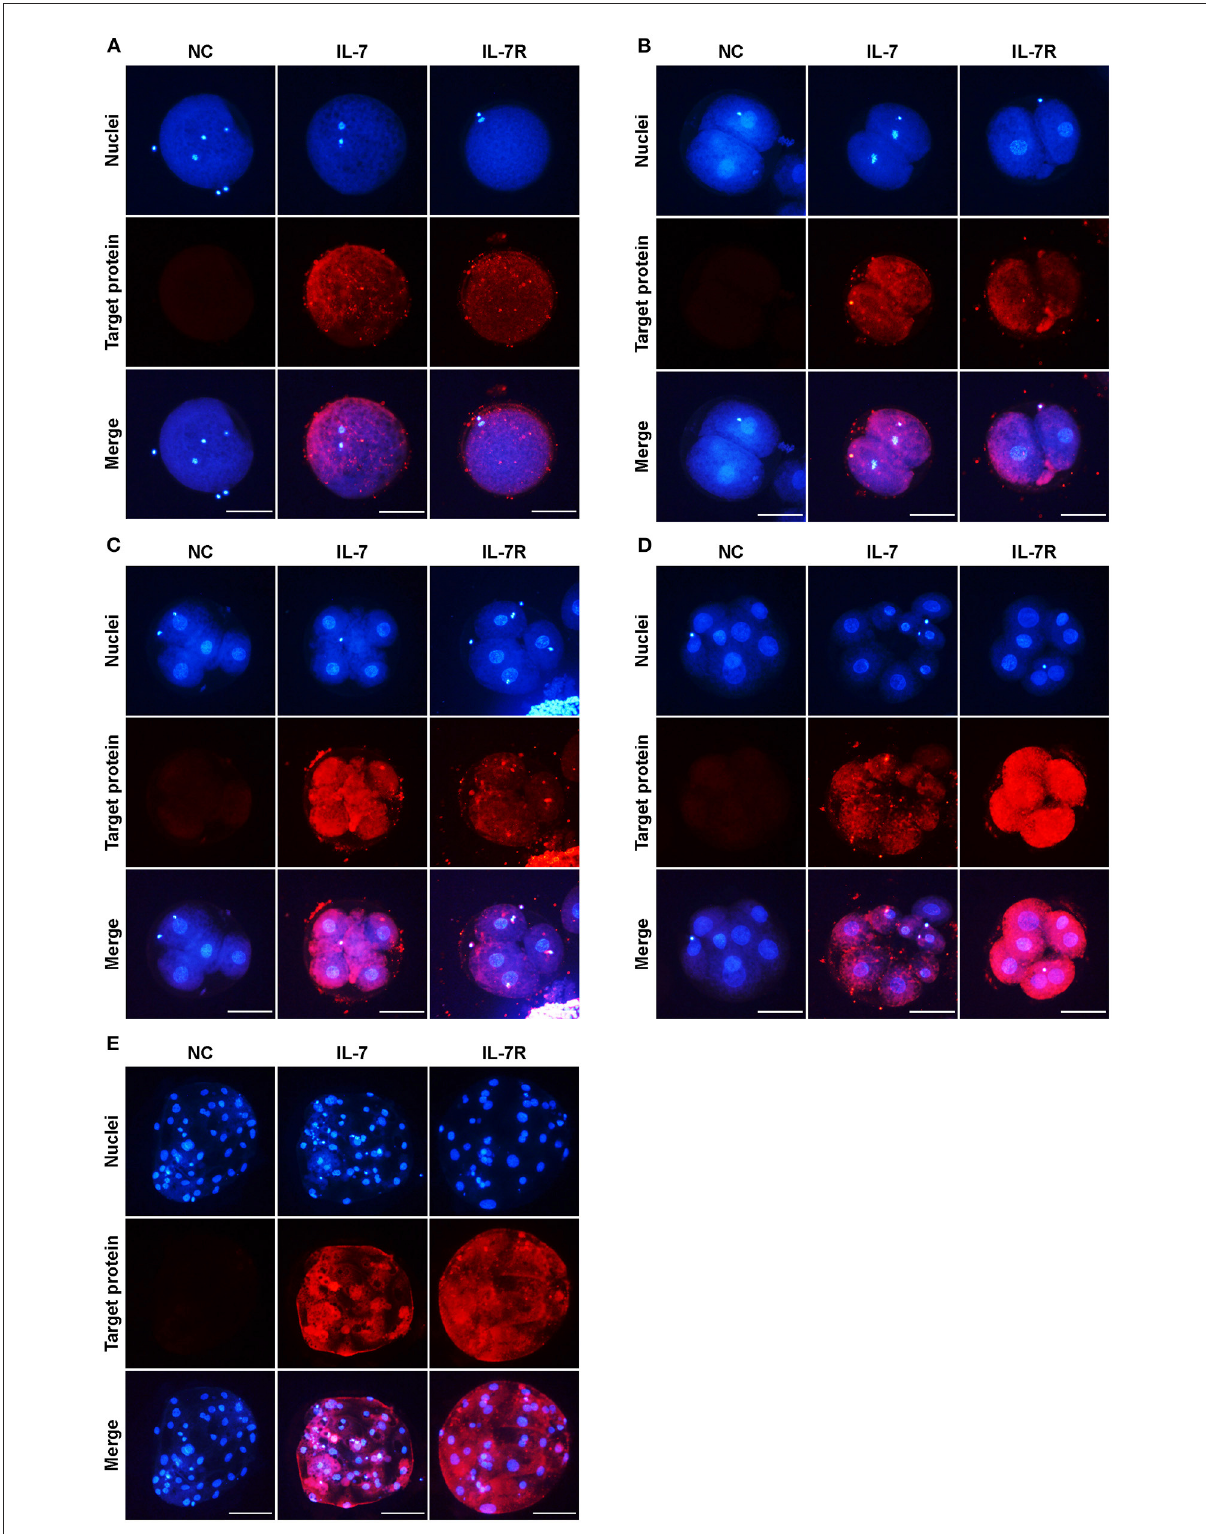
FIGURE1 Localization of IL-7 and IL-7R in preimplantation porcine embryos. Porcine oocytes at the metaphase II–stage (MII) (A) and embryos at the 2- (B) , 4- (C) , 8-cell (D) , and blastocyst (E) stages collected at 0, 24, 48, 72, and 168h after PA, respectively, were stained with antibodies against IL-7 and IL-7R. Scale bar: 100 µ